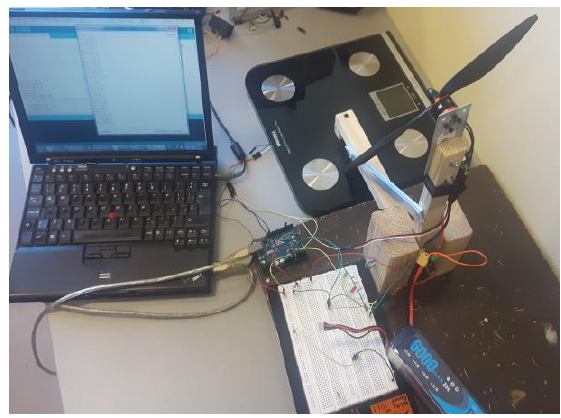
Fig. 5. Motor testing and UAV simulation system.